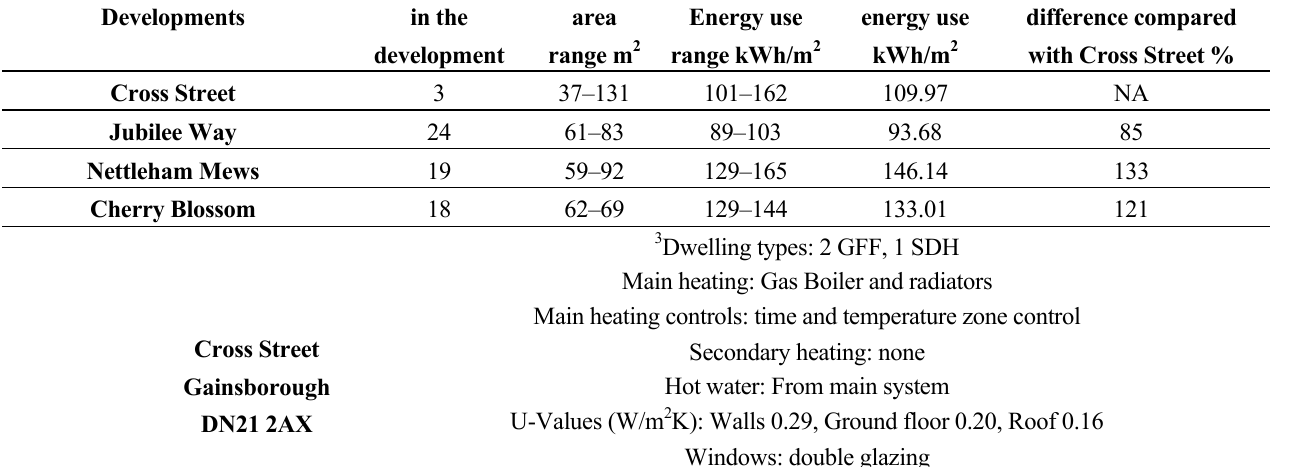
Table 8. Comparison of the annual energy demands of different developments.